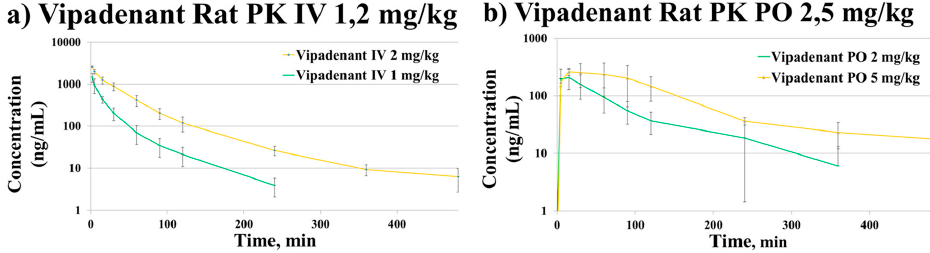
Table 4. The Species-dependent matrix effect of vipadenant.